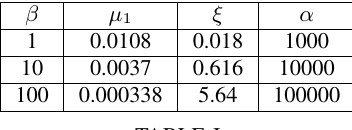
T HE PARAMETERS GIVEN IN THE ROW BEGINNING WITH β = 1 GENERATES THE RESULTS IN (3) TOP . T HE NEXT ROW FOR β = 10 GIVES (3) MIDDLE WITH THE FINAL ROW GENERATING (3) BOTTOM WITH β = 100 .